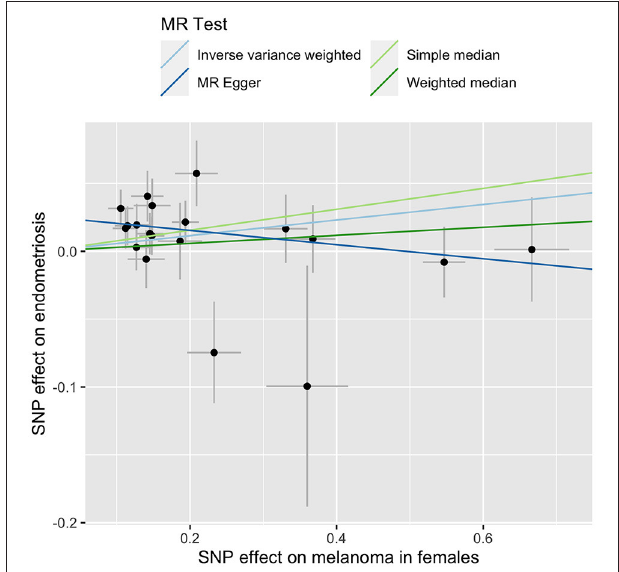
FIGURE 1 | MR-base results for melanoma in females (exposure) and endometriosis (outcome). Different line color represents a different MR test outlined in the